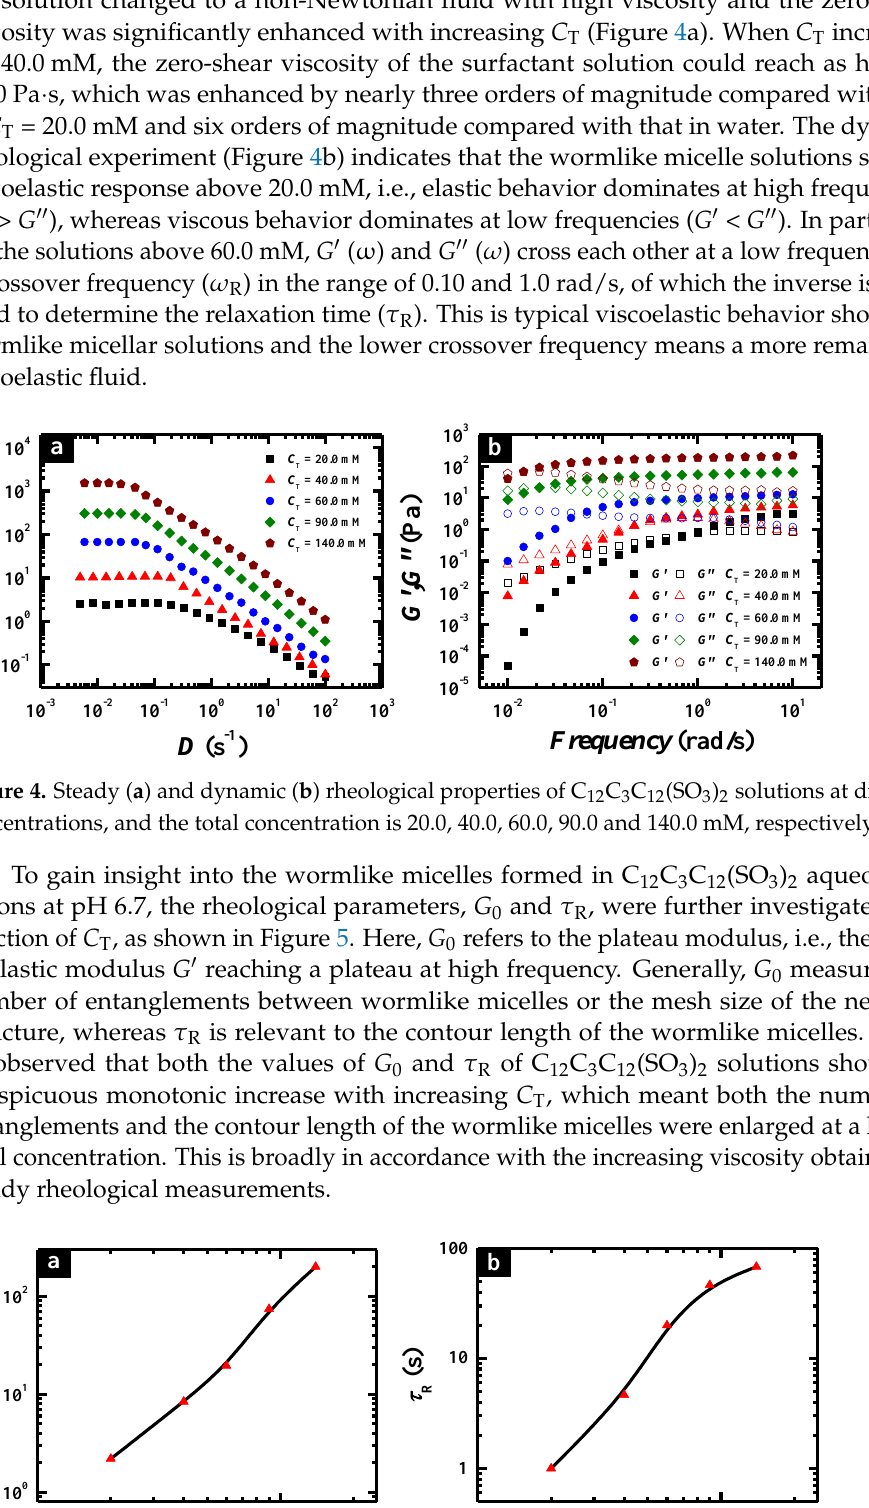
Figure 5. Variation of G 0 ( a ) and τ R ( b ) as a function of C T for C 12 C 3 C 12 (SO 3 ) 2 solutions at pH 6.7.